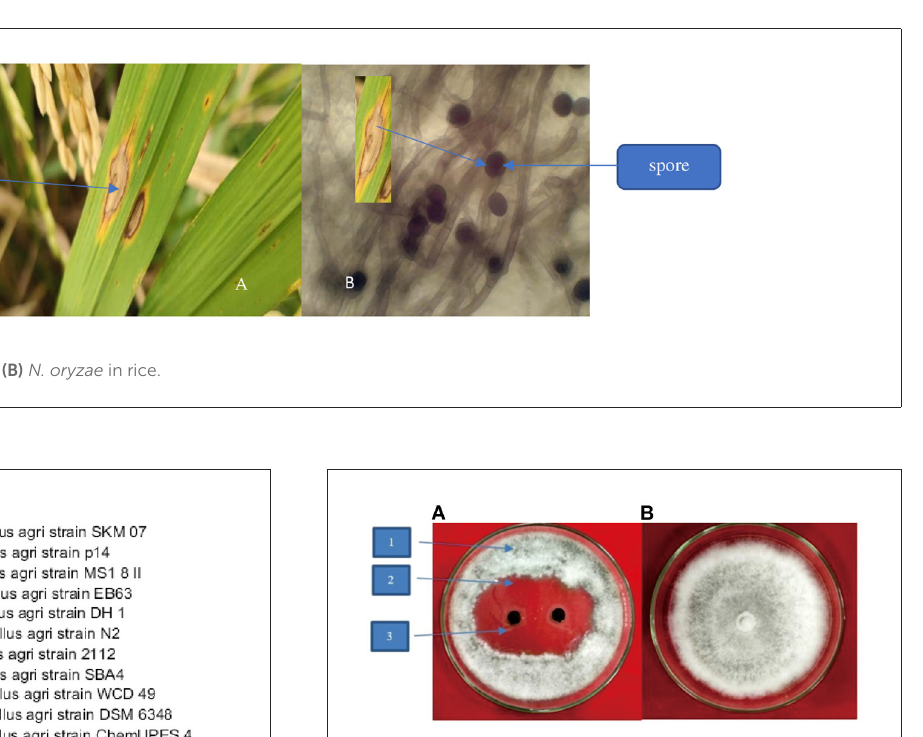
FIGURE4 (A) Inhibitory of crude leaves extract of P. caninum against N. oryzae ; 1- N. oryzae , 2-crude leaf extract, 3-clear zone (B) Control.